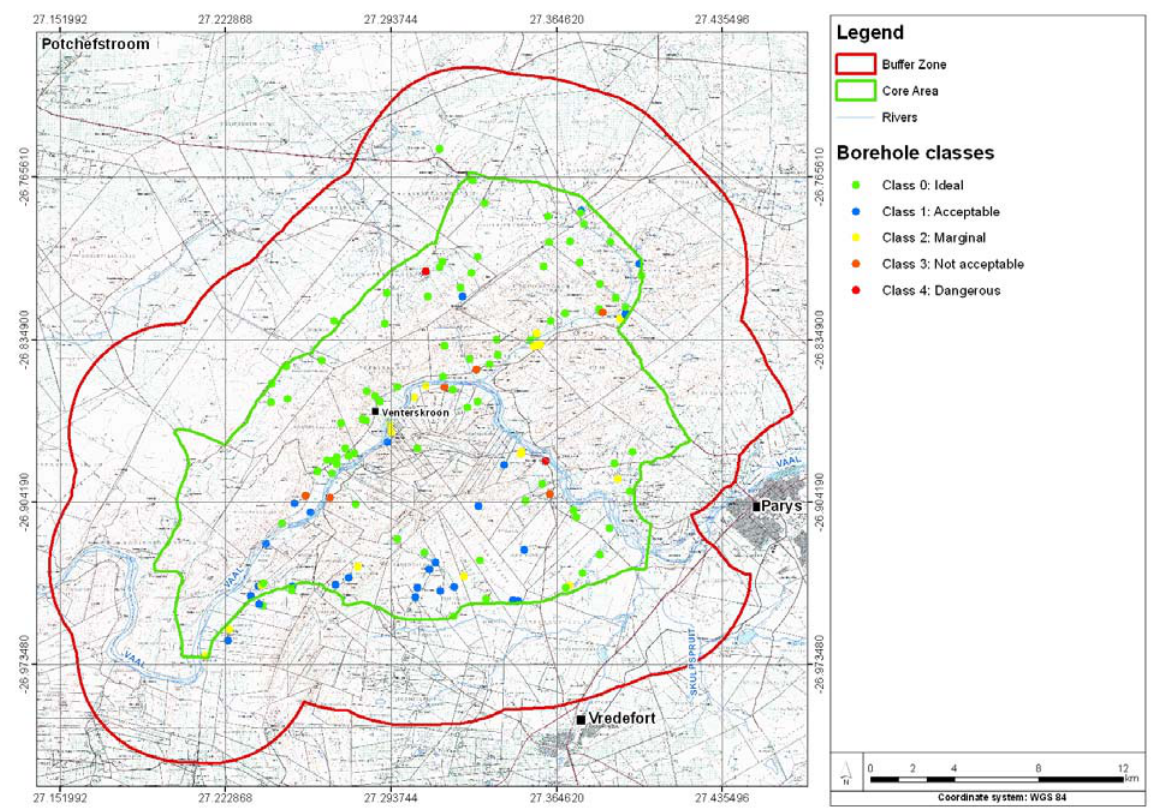
Figure 9. Groundwater quality in the